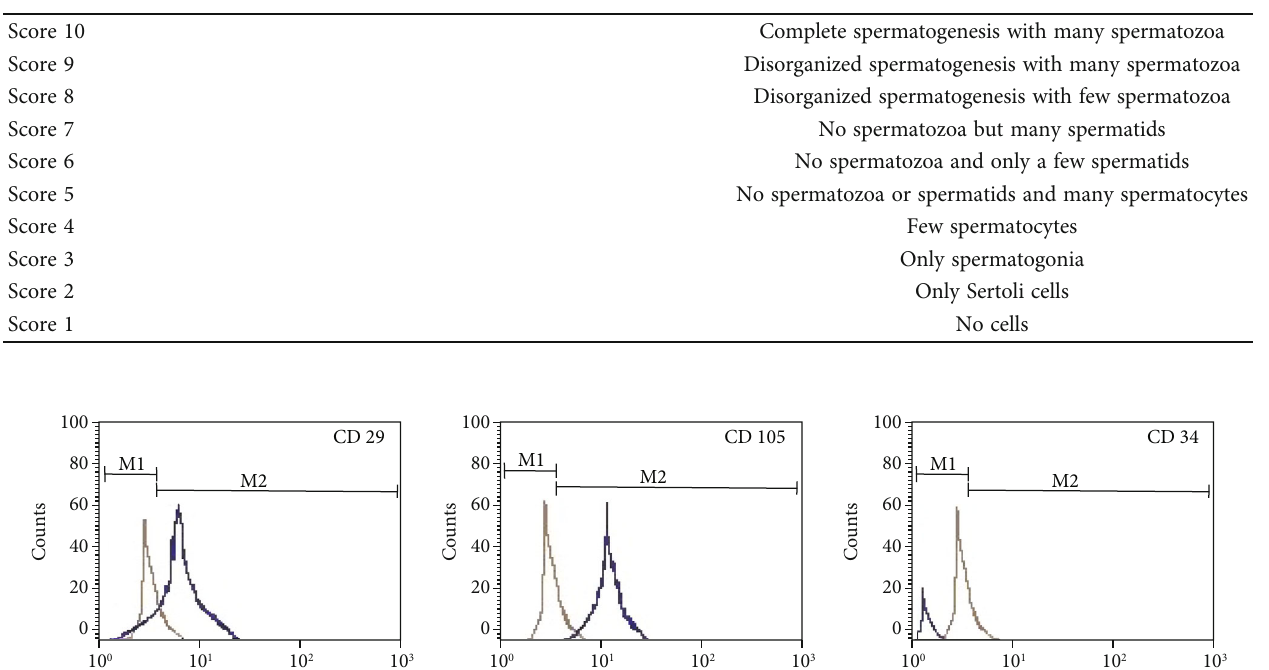
Table 1: Evaluation of the right testicular tissue using the Johnson tubular biopsy score (JTBS) for grading the damage [36].